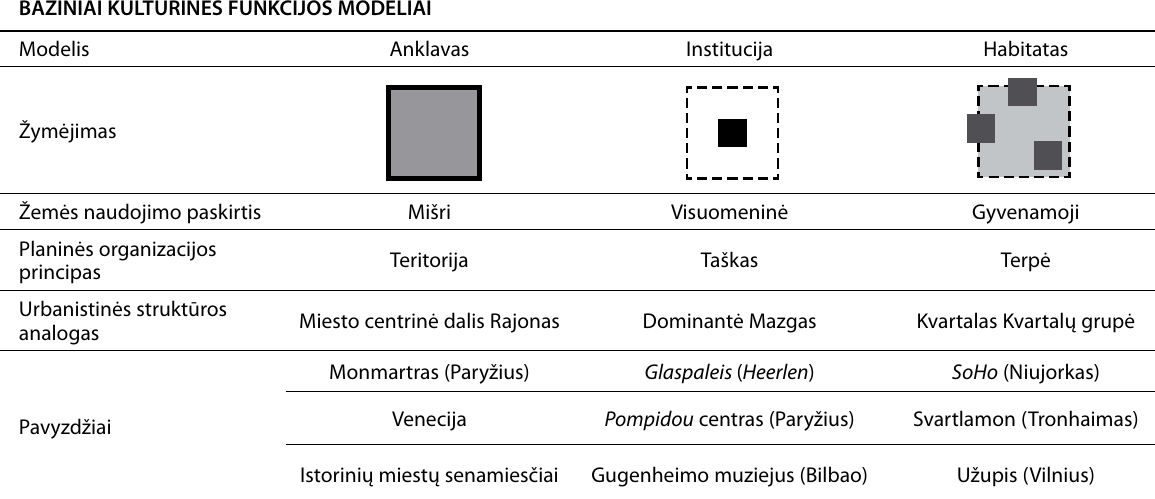
Table 1. basic models of city‘s cultural function and their